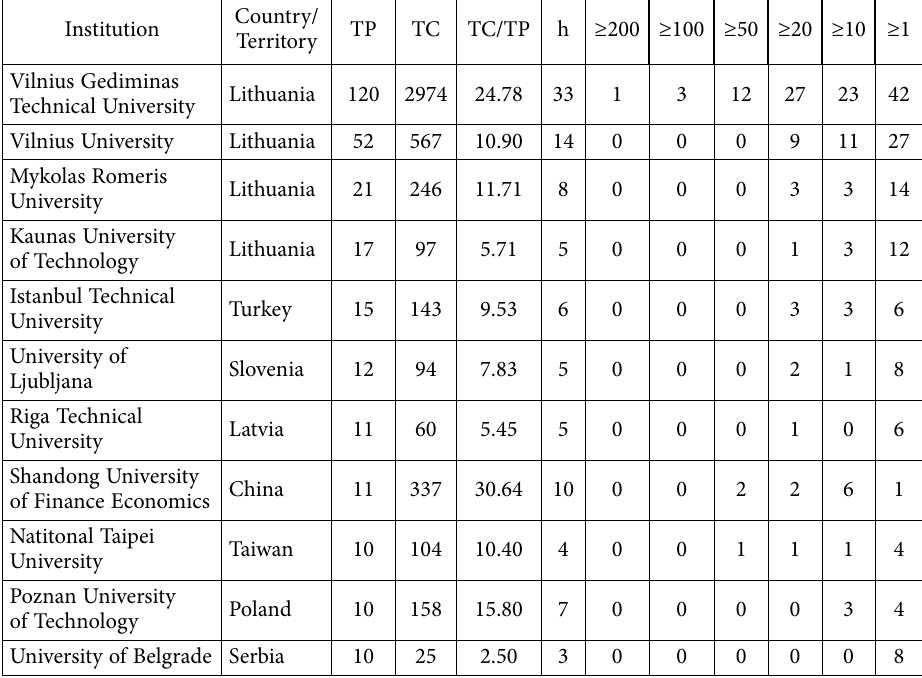
Table 6. Productive and influential institutions of the TEDE journal